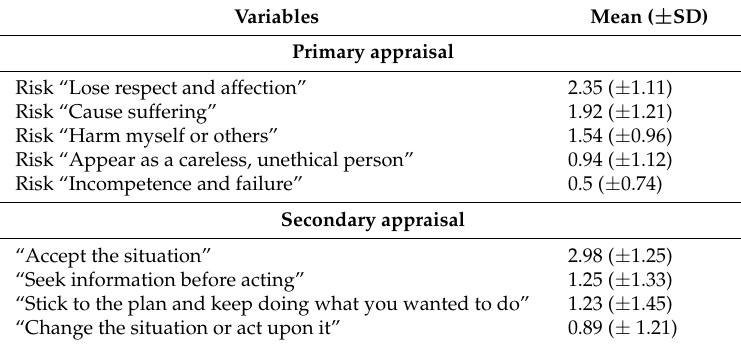
Table 1. Means and Standard deviation of key variables (cognitive appraisal, emotions, and coping during the disclosure of sexual orientation the most